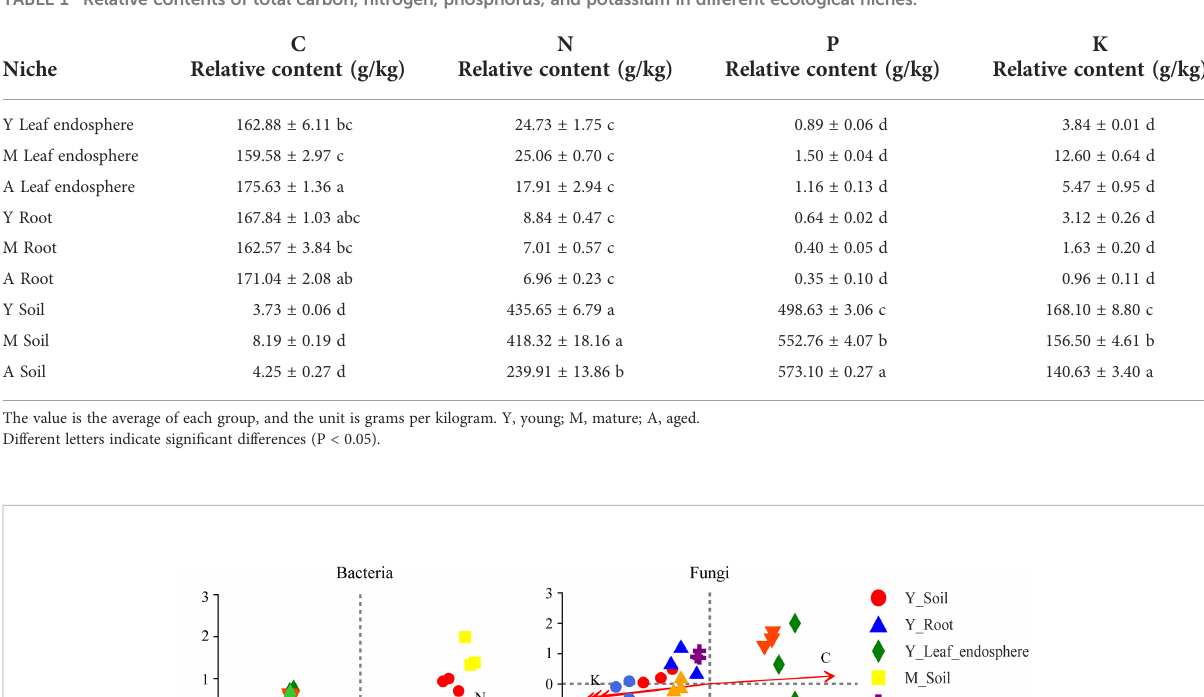
TABLE 1 Relative contents of total carbon, nitrogen, phosphorus, and potassium in different ecological niches.